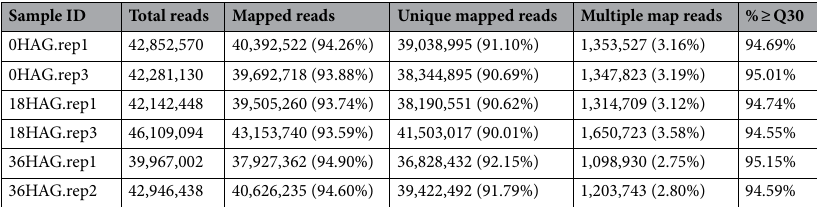
Table 1. Statistic of RNA-seq data on the soybean genome.